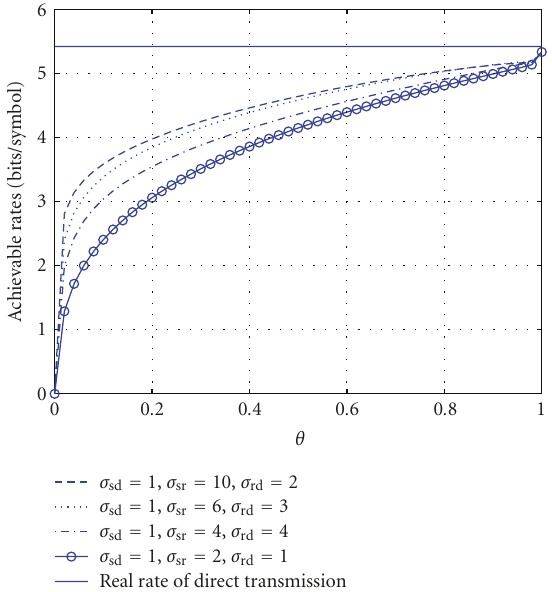
Figure 10: Overlapped AF achievable rate versus θ . P = 100, and m =